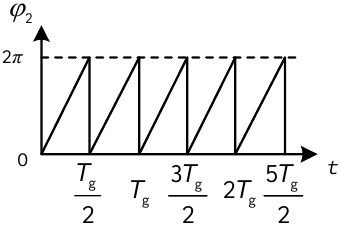
Figure 4. The modulation scheme of φ 2 .